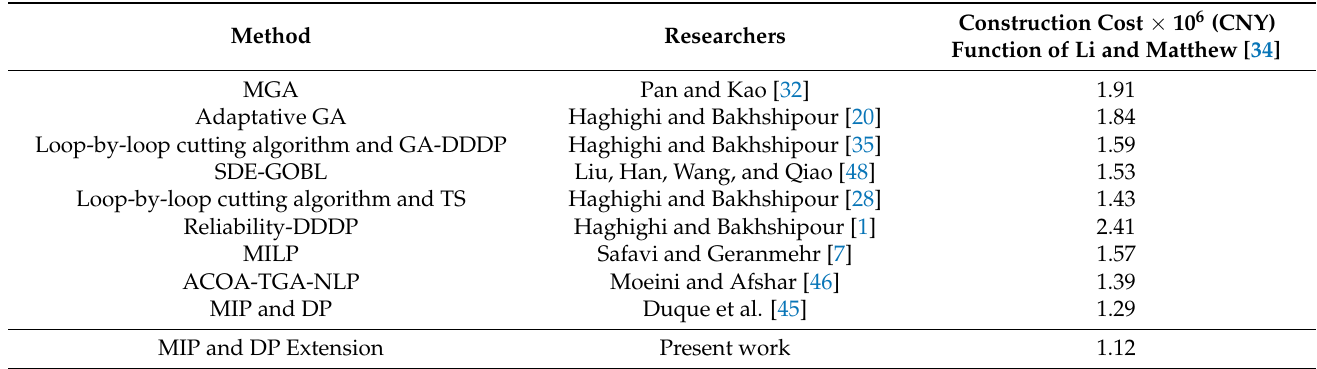
Table 4. Construction cost with different methods for the benchmark proposed by Li and Matthew